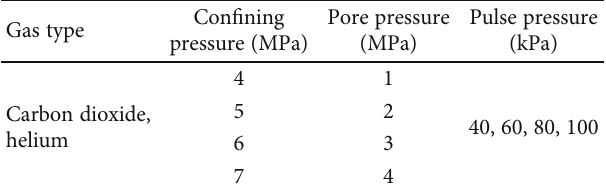
Figure 2: Sketch of the experimental setup for the permeability measurement. Table 1: Experimental scheme for the permeability